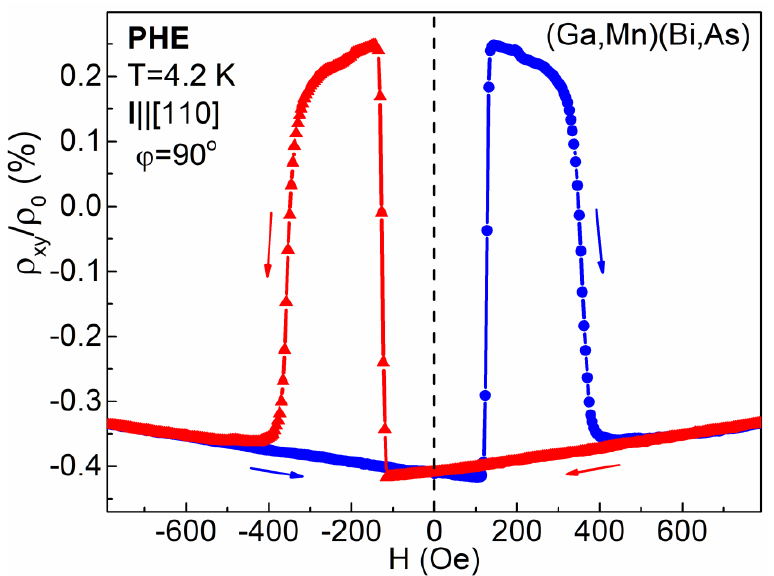
Figure 2. Normalized PHE resistivity for the (Ga,Mn)(Bi,As) micro-Hall-bar measured at the temperature 4.2 K, while sweeping an in-plane magnetic field, perpendicular to the current ( φ = 90°), in opposite directions, as indicated by the arrows.